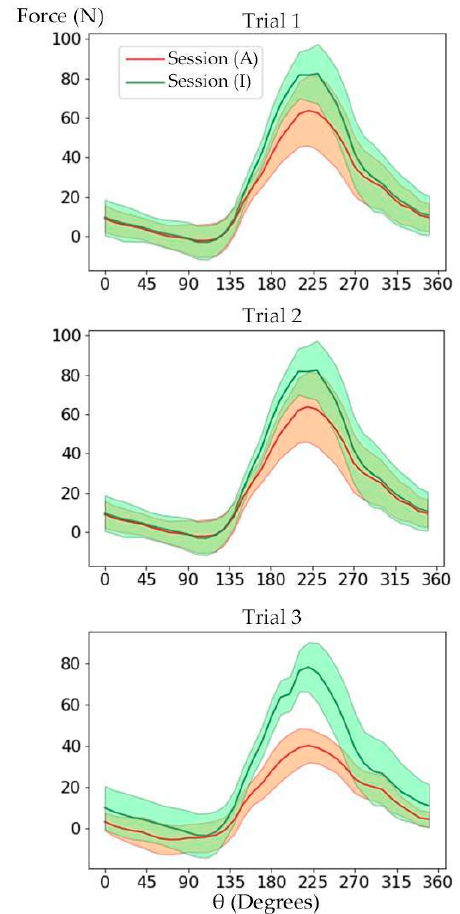
Figure 7. The perpendicular pedal force of the target leg was measured by the strain gauge system. The force curves over a crank revolution during sessions (A) and (I) were averaged. The highlighted regions show the standard deviation. The negative force represents the crank positions for which the crank perpendicular force creates a torque in the opposite direction of motion, performing a negative work. This happened mainly for the crank angle 270° to 360 + 90°, when the leg weight applied a negative torque. Table 2. The AUC of the crank force of the target leg. The APAD was active during session (A), providing pedaling torque assistance to the target leg. Numbers inside parentheses are standard deviations. A t -test was conducted to compare values in sessions (A) and (I).